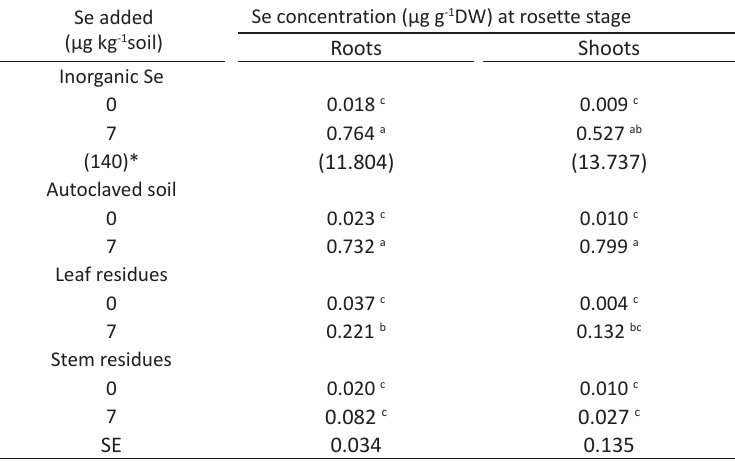
Table 3. Se concentration (µg g -1 DM) in roots and shoots of B. napus L. plants grown in soil that had been treated with inorganic Se (0, 7 and 140 µg kg -1 soil), organic Se (leaf and stem residues, 0 and 7 µg kg -1 soil) and in autoclaved soil with inorganic Se (0 and 7 µg kg -1 soil) at the rosette stage Se added (µg kg -1